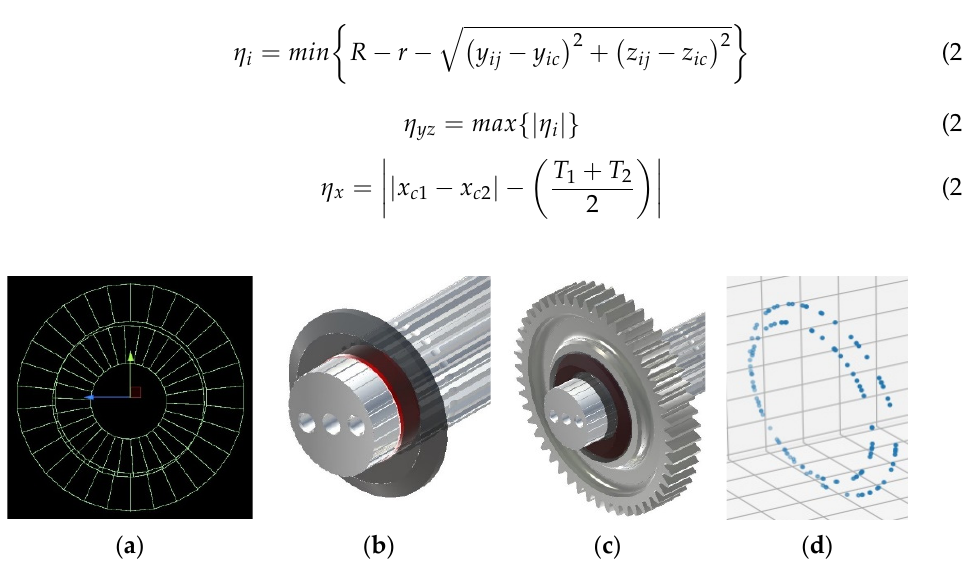
Figure 19. Interference data. ( a ) Schematic diagram of grid interference. ( b ) Shaft hole interference. ( c ) Surface interference. ( d ) Interference point cloud data. (cid:1) (cid:0) x ij , y ij , z ij is the centroid coordinates of the jth mesh cell on the assembly part